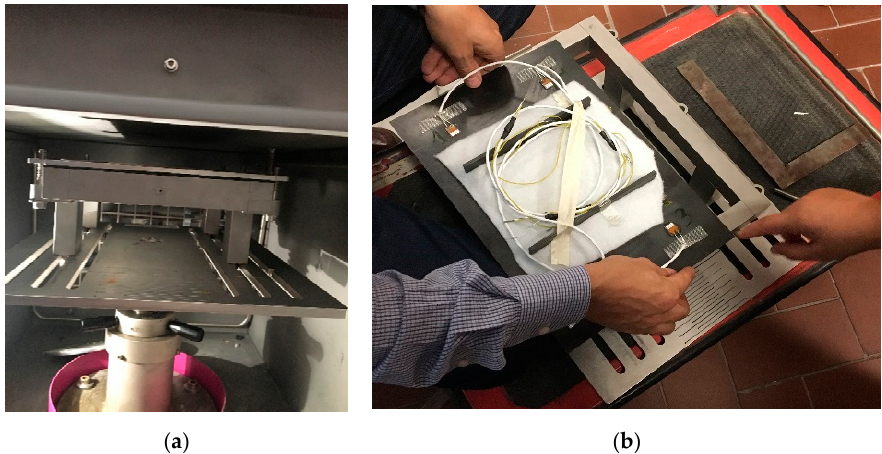
Figure 3. Test rig: drop-weight machine ( a ); aluminum fixture for the panel ( b ).